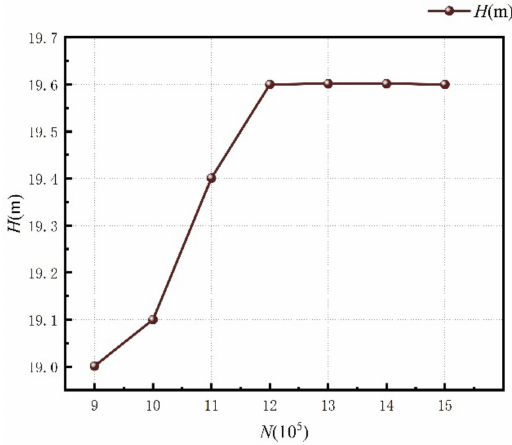
Figure 4. The grid independence